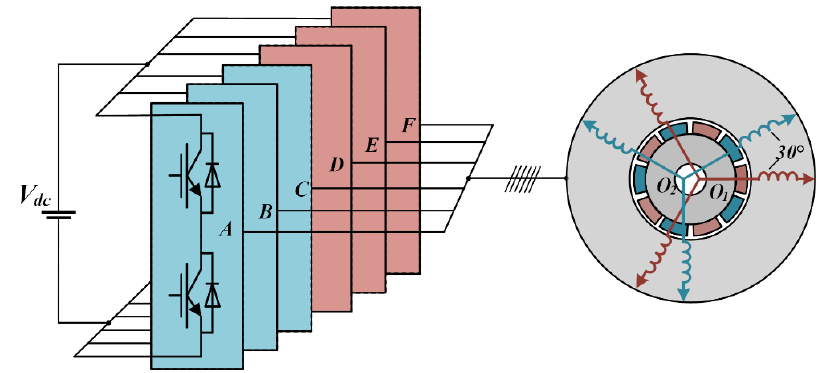
Figure 1. Scheme of the dual three-phase PMSM drive.